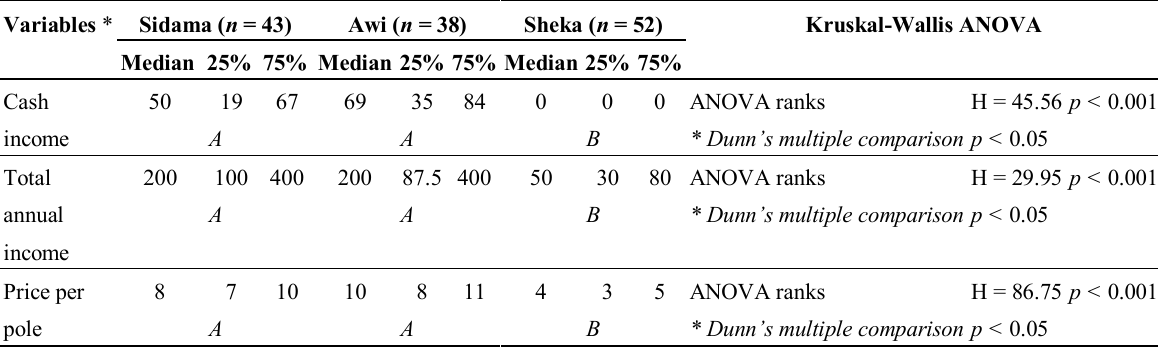
Table 2. Variation in total bamboo consumption (in birr) and degree of commercialization in three Ethiopian study regions.